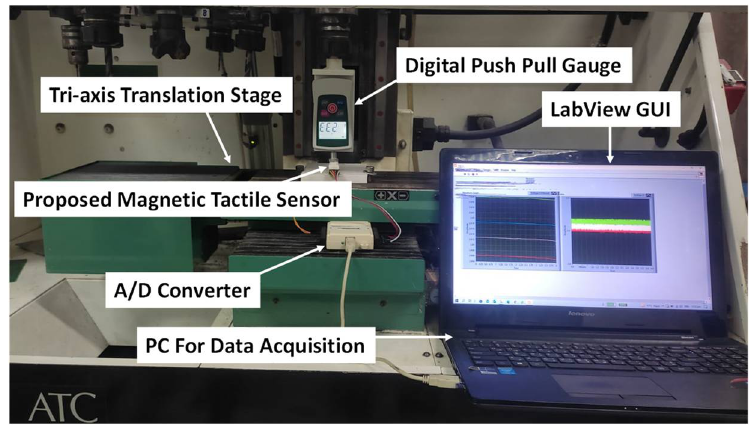
Figure 8. Experimental setup for the characterization of the magnetic tactile sensor.